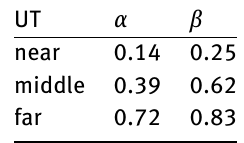
Table 2: α and β values.